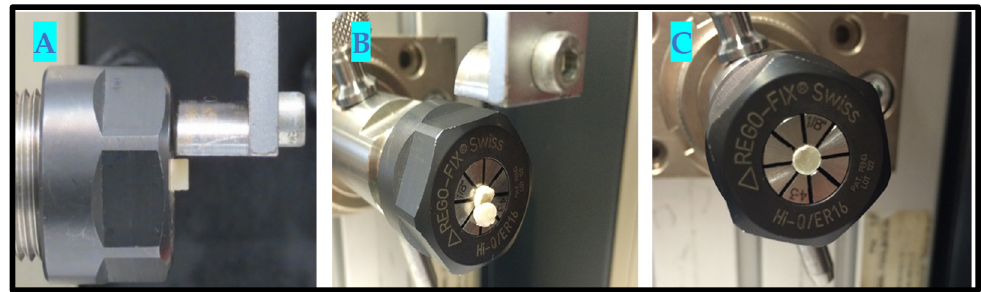
Figure 5. ( A ) Intact sample, ( B ) sample after force was applied, ( C ) junction of one restorative after